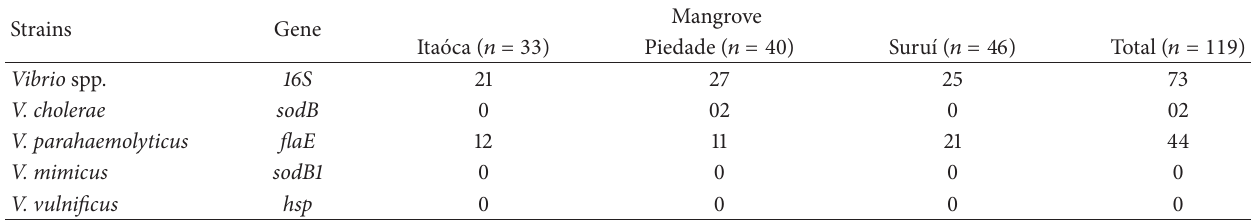
Table 4: Distribution of Vibrio strains by mangrove.